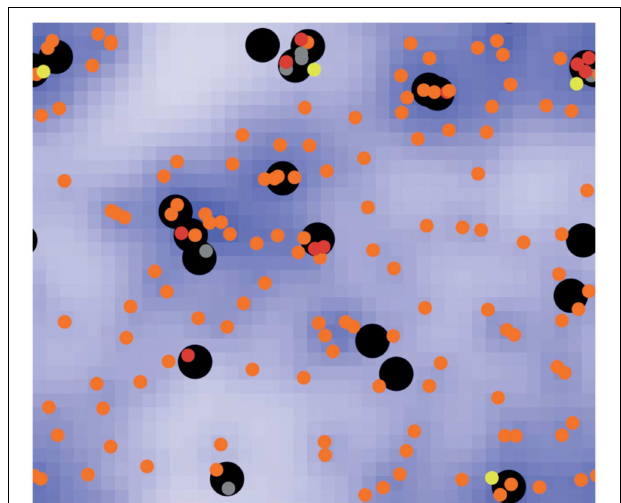
FIGURE 2 | Screenshot of a typical ABM simulation (taken from Tokarski et al., 2012), displaying the hunt of free-moving neutrophil agents (black circles) for immobile spore agents of Aspergillus fumigatus in human lung tissue. Spores can be free (orange), temporarily dragged (yellow) or caught (red) by a neutrophil agent. Dragged spores may be released with a certain probability or caught and phagocytosed (gray). Neutrophil agents are able to detect chemokines (blue), released by spores during sporulation, and may adjust their movement